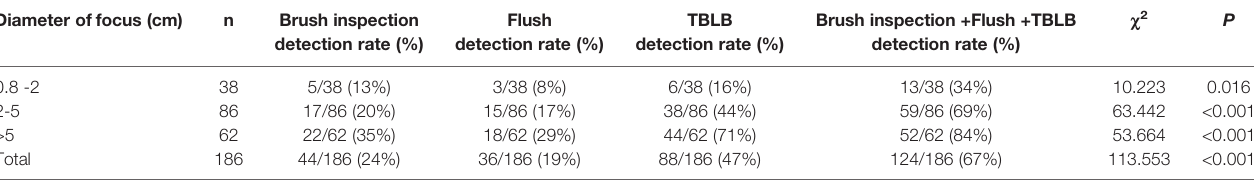
TABLE 1 | Comparison of different sampling methods for different lesions of different sizes under fi beroptic bronchoscopy. Diameter of focus